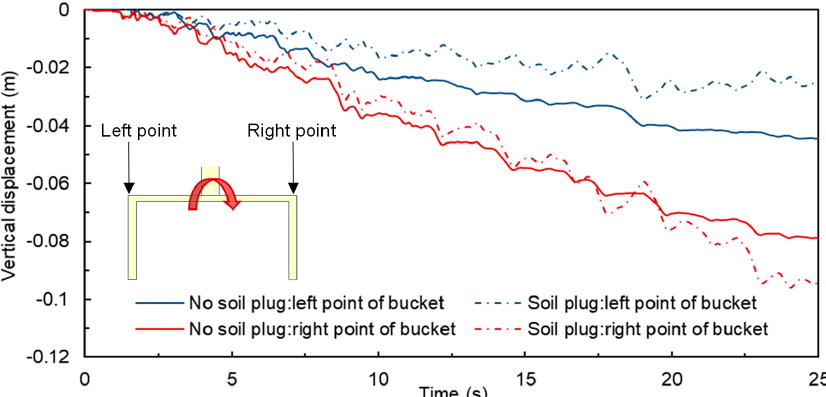
Figure 11. The residual horizontal displacement of bucket: ( a ) shaking direction; ( b ) the direction perpendicular to shaking. The settlement time histories at the left and right corner points of the wide bucket foundation (WBF) in inclined liquefiable seabeds are shown in Figure 12. The existence of soil plug increased the nonuniform settlement of bucket, where a slight increase in the peak settlement in the right point of bucket was observed. peak settlement in the right point of bucket was observed.